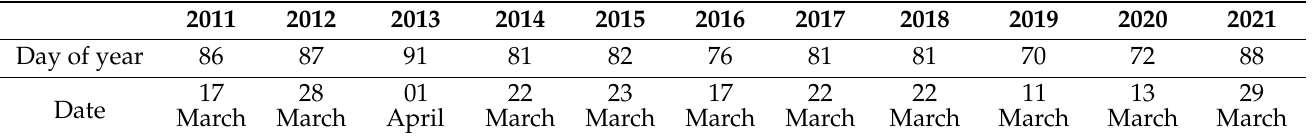
Table A1. The start date of spring pollen allergy outbreak extracted from microblog data.